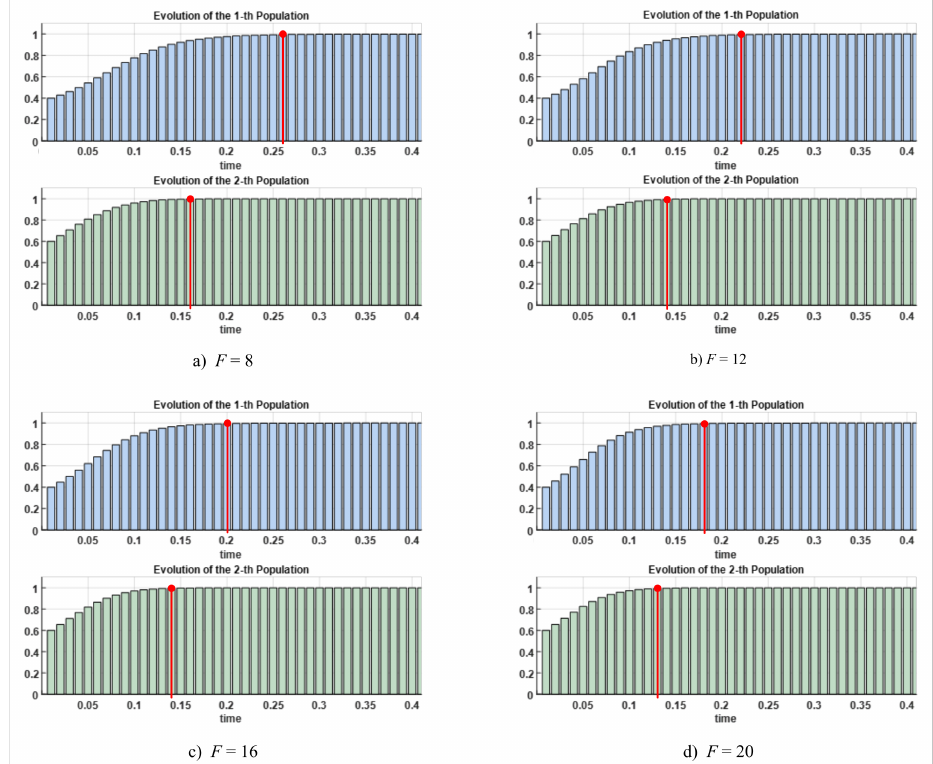
Figure 5. Influence of F change on system